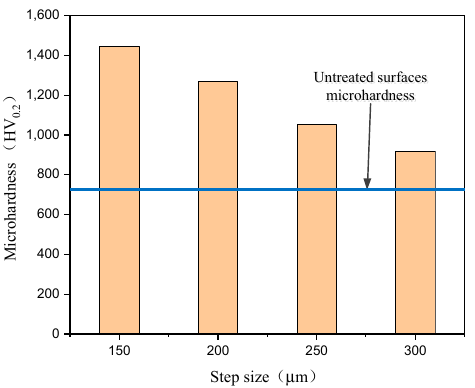
8 of 16 Figure 5. Diagram of contact angles of different surfaces: ( a ) untreated surfaces; ( b ) superhydro- philic surface; ( c ) superhydrophobic surface. 3.4. Surface Microhardness The surface microhardness is measured at five different locations on top of the un- treated Ti surface and laser-textured Ti surfaces with different wettabilities, and the aver- age value is reported. It can be seen in Figure 6 that the microhardness of the laser-tex- tured surface is drastically increased compared with that of the untreated surface. In the meantime, the microhardness values for the laser-textured surfaces using different steps size are also quite different, and it is found that the microhardness increases as the step size decreases. This is mainly ascribed to the following reasons: Laser surface texturing